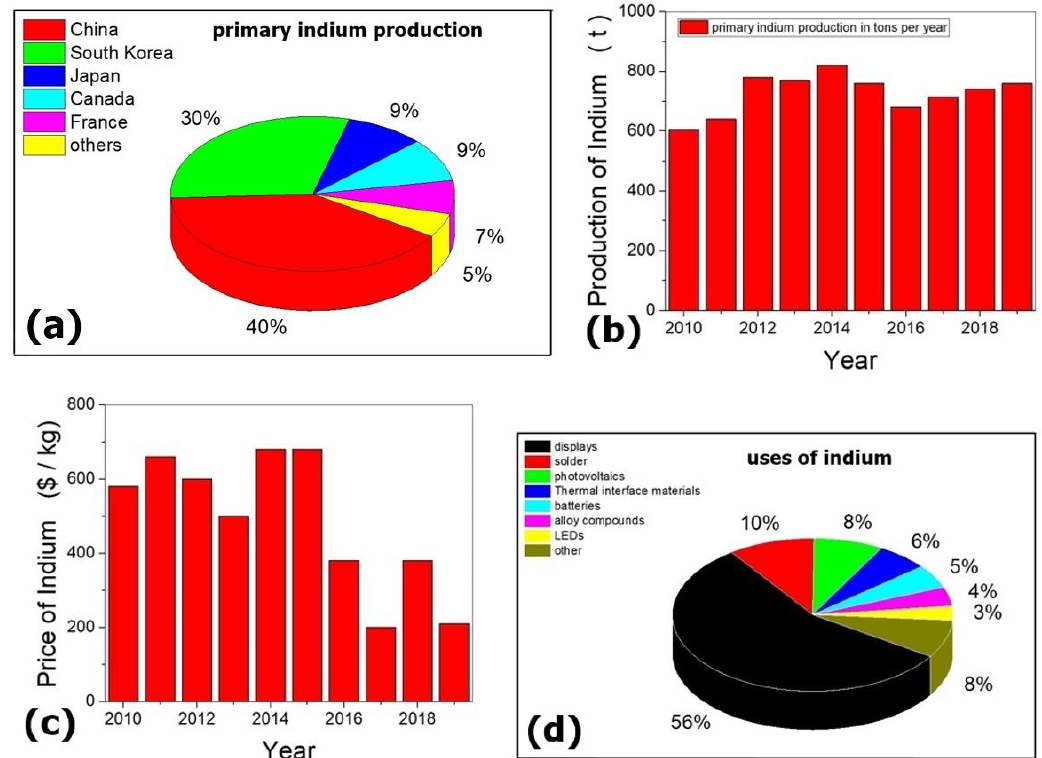
Figure 1. ( a ) Proportion of primary indium production for the main producer countries, China, South Korea, Japan, and Canada in 2018. ( b ) Quantity in tons of worldwide primary indium production per year for the last decade (2010–2019). ( c ) Price of indium in US$ per kg for the last decade (2010–2019). ( d ) The main uses of indium can be found in the production of flat panel displays, as solder and in photovoltaics/solar cells, 2015. [Data collected from references [1–5]].